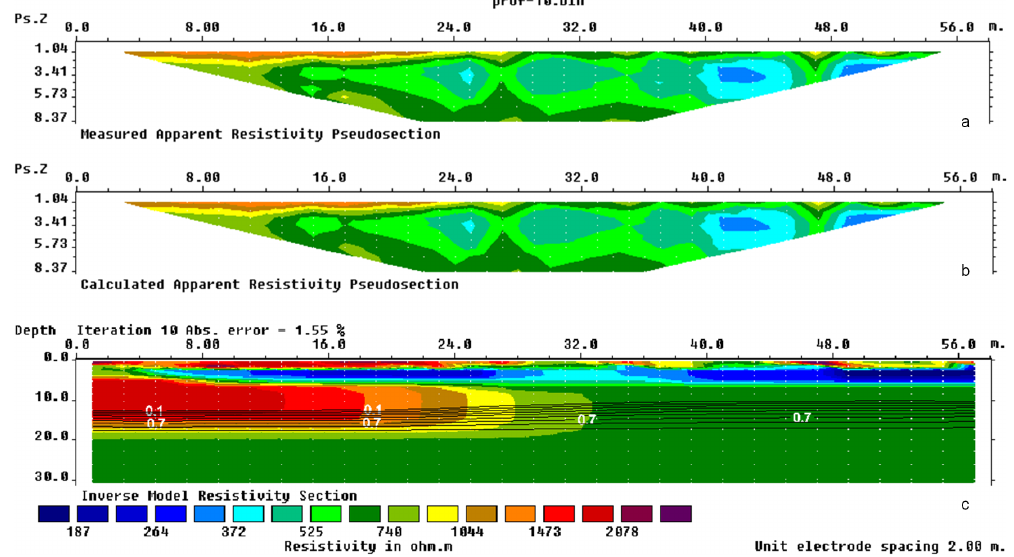
Fig. 4. Apparent resistivity data from the considered 2-D ERT profile are shown in (a) , while the calculated apparent resistivity data are in (b) . The model recovered from the inversion, with a reference model equal to the average of the collected apparent resistivity data (650 (cid:127) m), is in (c) . The DOI values of Fig. 3c are superimposed on the model with a contour line interval of 0.1.